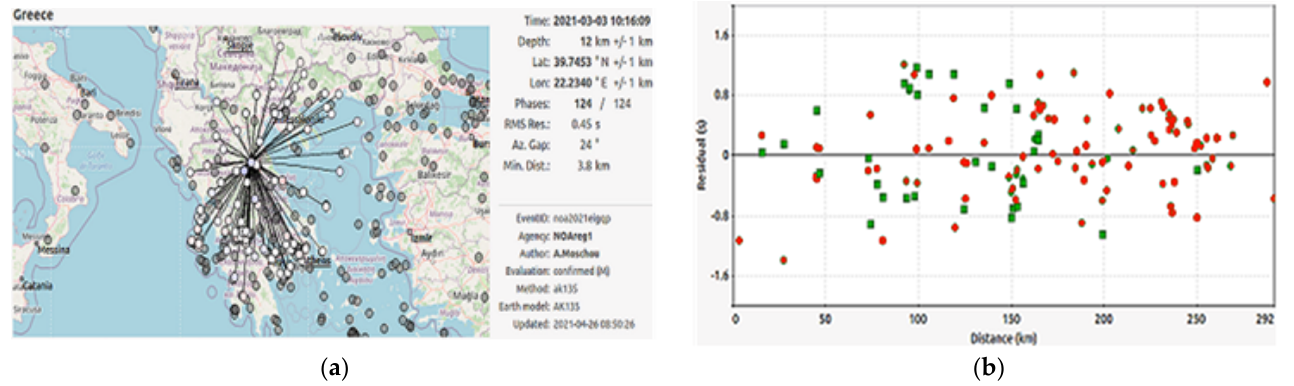
Figure 5. ( a ) Azimuthal distribution of the stations used to calculate the epicenter of the 3 March 2021 (10:16:08.39, UTC) and the characteristics of the solution; ( b ) graph of the distance (km)–residual (s) stations. The green squares represent the stations where only vertical components (P-waves) were used, while the red circles represent the stations where both vertical and horizontal components (P-waves and S-waves) were used.